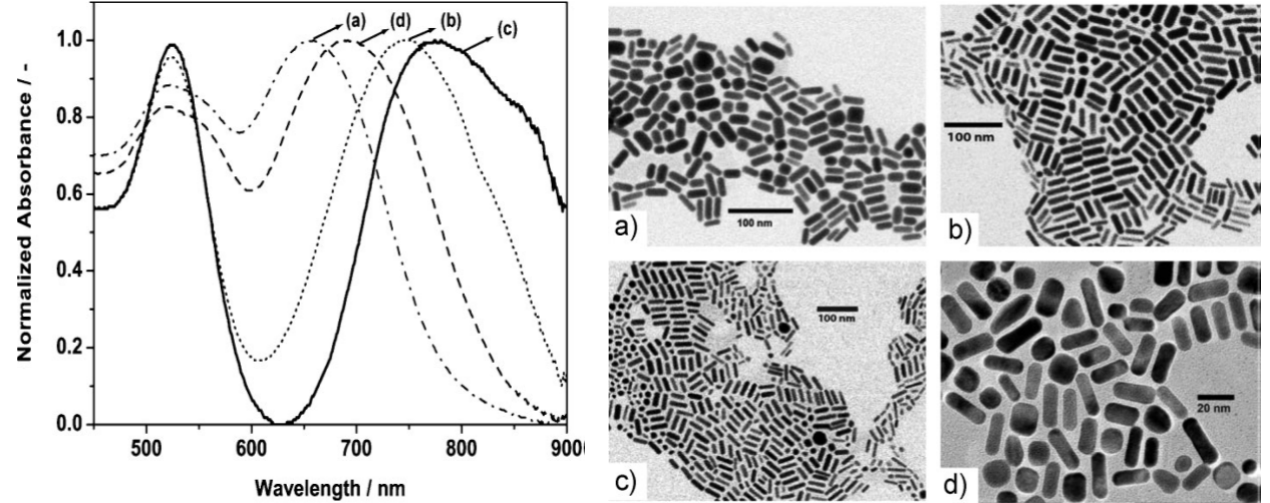
Figure 22. UV/Vis absorbance spectra and the corresponding TEM images of rod-shaped particles of varying aspect ratios